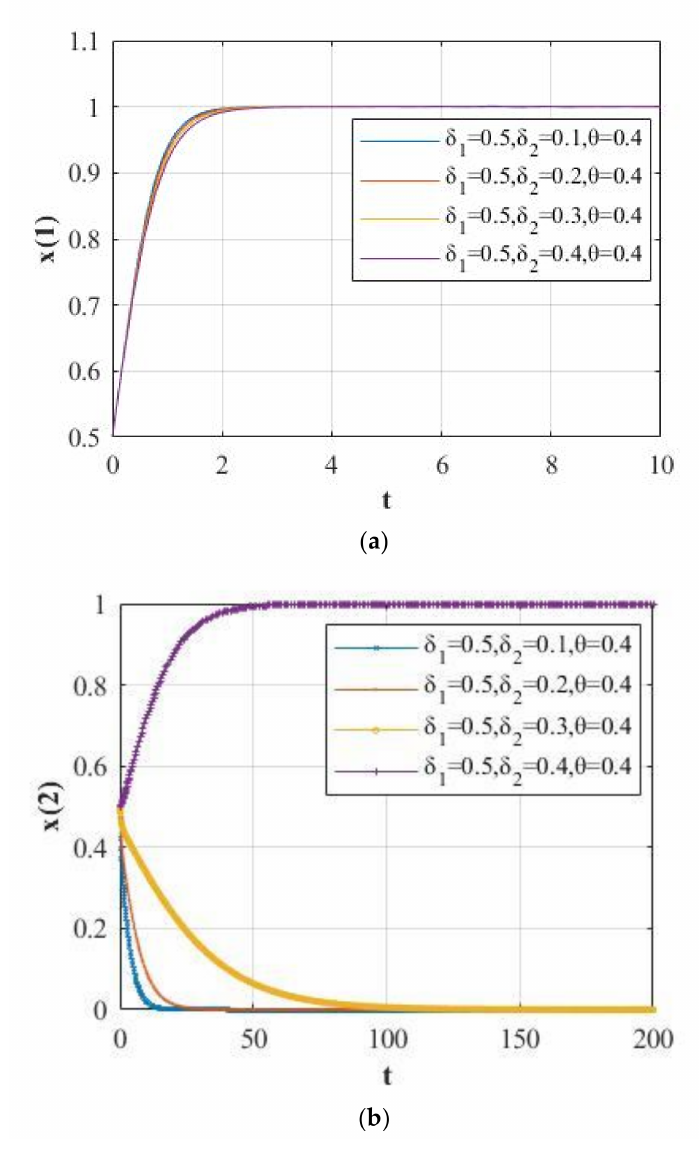
Figure 9. ( a ) While changing δ 2 and δ 1 = 0.5, θ = 0.4., evolution diagram of government’s su- pervision option. ( b ) While changing δ 2 and δ 1 = 0.5, θ = 0.4., evolution diagram of